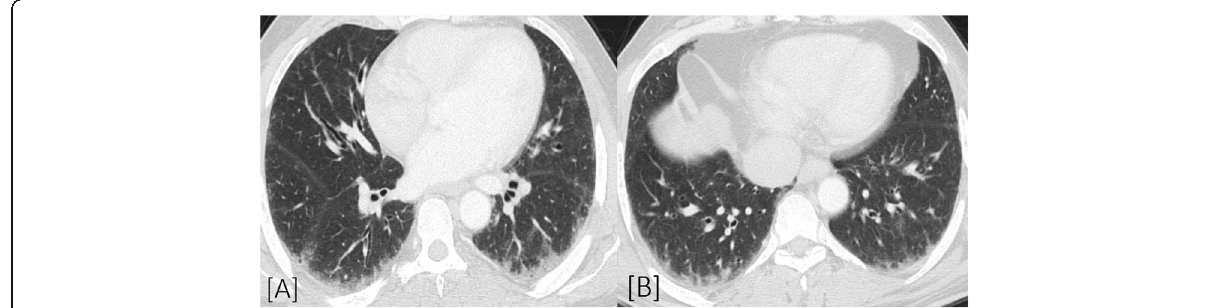
Fig. 4 A 51-year-old patient with active hepatitis, normal PFT, and mild dyspnea. a , b Axial HRCT showing bilateral sub-pleural GGO without appreciable reticular changes. Cellular